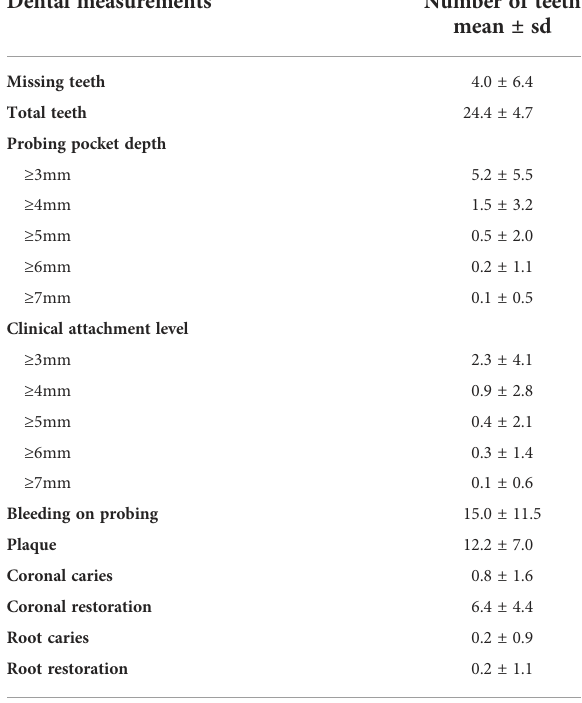
TABLE 2 Participant dental